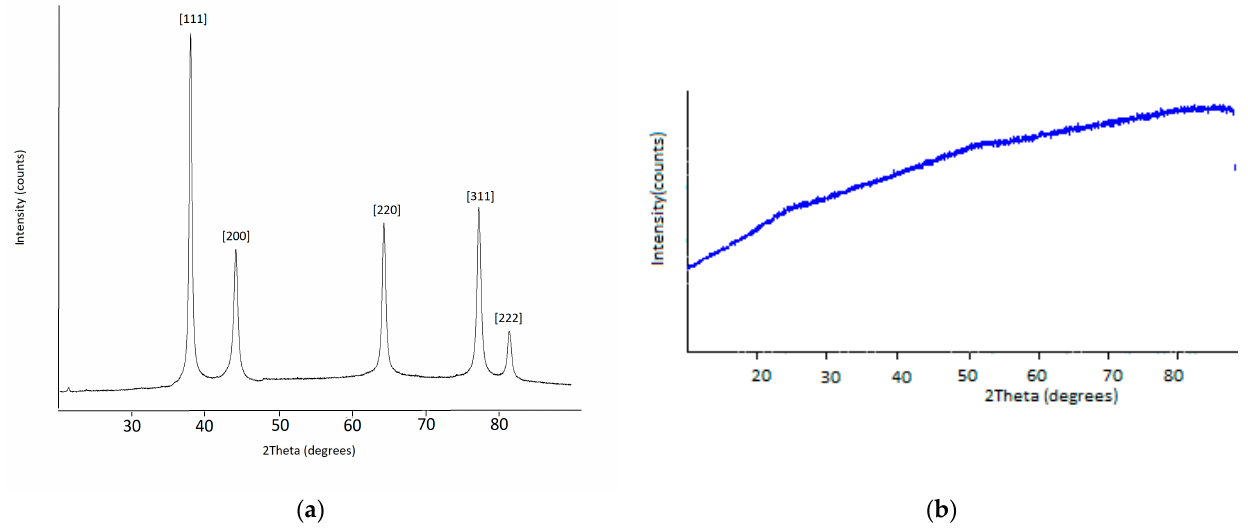
Figure 10. PXRD diffractograms of Au NPs ( a ) and FeO x NPs ( b ).